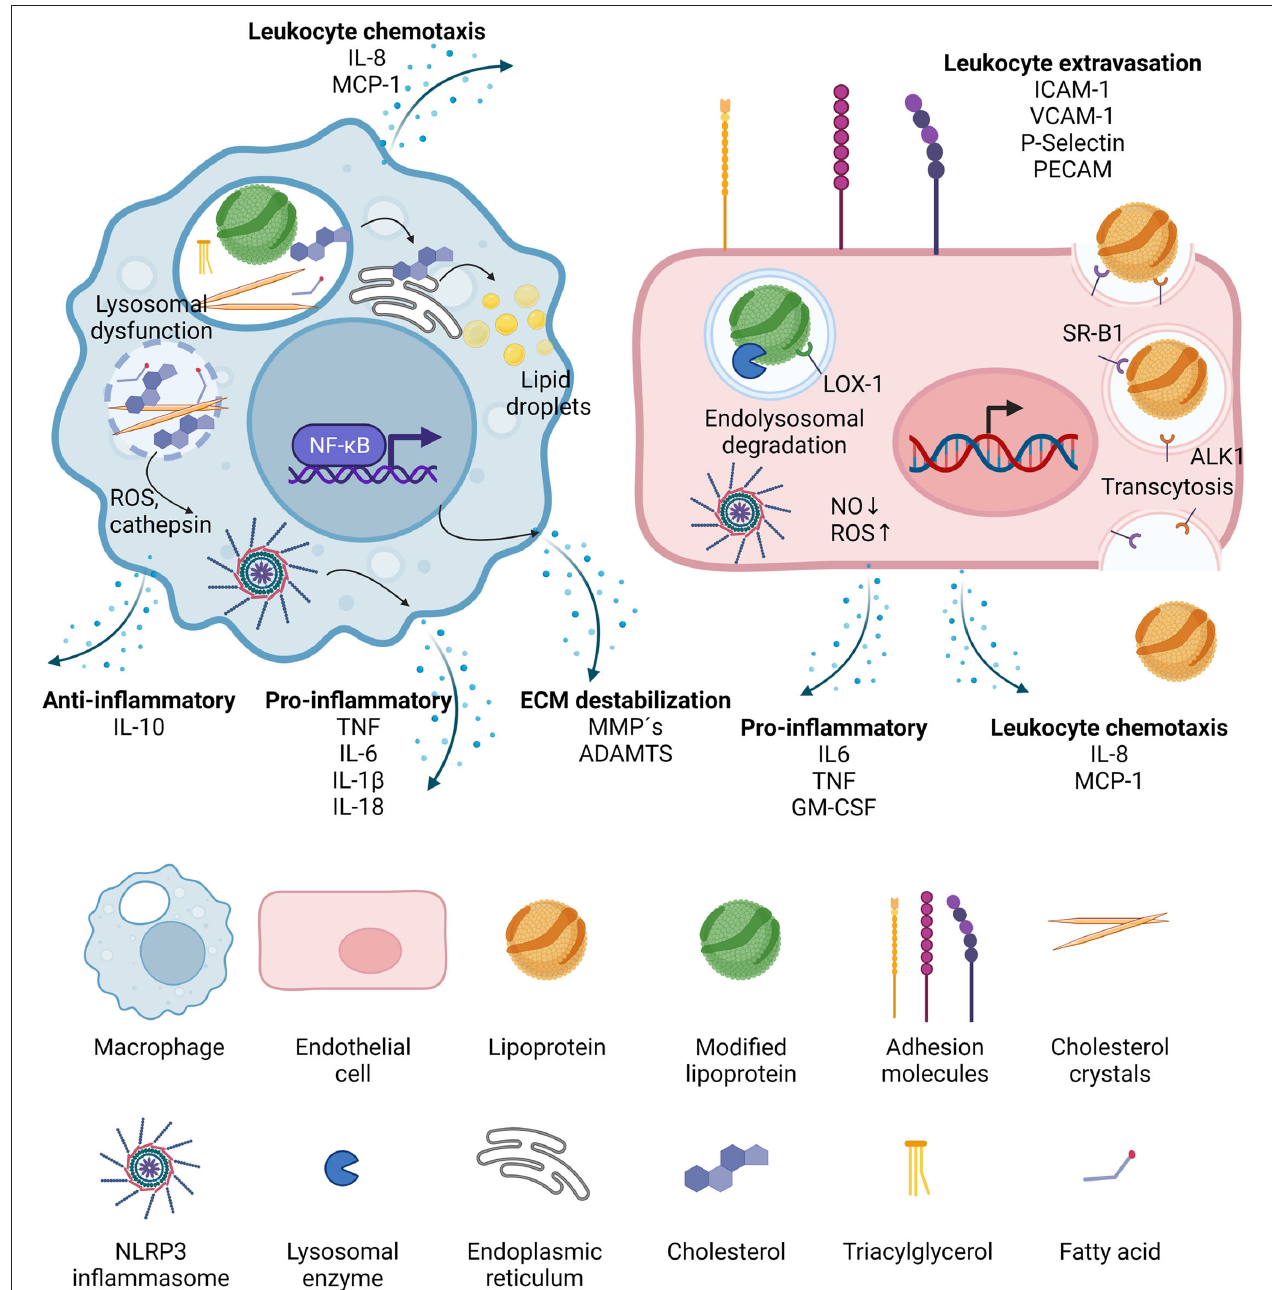
FIGURE 2 | Effects of lipoproteins on macrophages and endothelial cells. Upon phagocytosis, modified lipoproteins are hydrolyzed in the lysosomes of macrophages. Cholesterol is then transported to the ER where it is packaged in lipid droplets for storage. It can also crystalize in the lysosomes, leading to lysosomal dysfunction and the release of reactive oxygen species (ROS) and cathepsins, which in turn activate cytosolic inflammasomes. NF- κ B signaling is induced and the activated macrophages secrete leukocyte chemotactic molecules, pro- as well as anti-inflammatory cytokines, and proteases. In endothelial cells, lipoproteins can be transported through the cell via transcytosis, mediated by binding to scavenger receptor B1 (SR-B1) and activin-like kinase 1 (ALK1). If the lipoproteins have been modified, they can also bind to lectin-type oxidized LDL receptor 1 (LOX-1) and then targeted to the lysosomes after internalization. LOX-1 activation leads to decrease in nitric oxide (NO) and increase in reactive oxygen species (ROS), the latter being able to trigger NLRP3 inflammasome activation. Activated endothelial cells increase the expression of adhesion molecules which accelerates leukocyte extravasation, and they also secrete leukocyte chemotactic factors, as well as pro-inflammatory